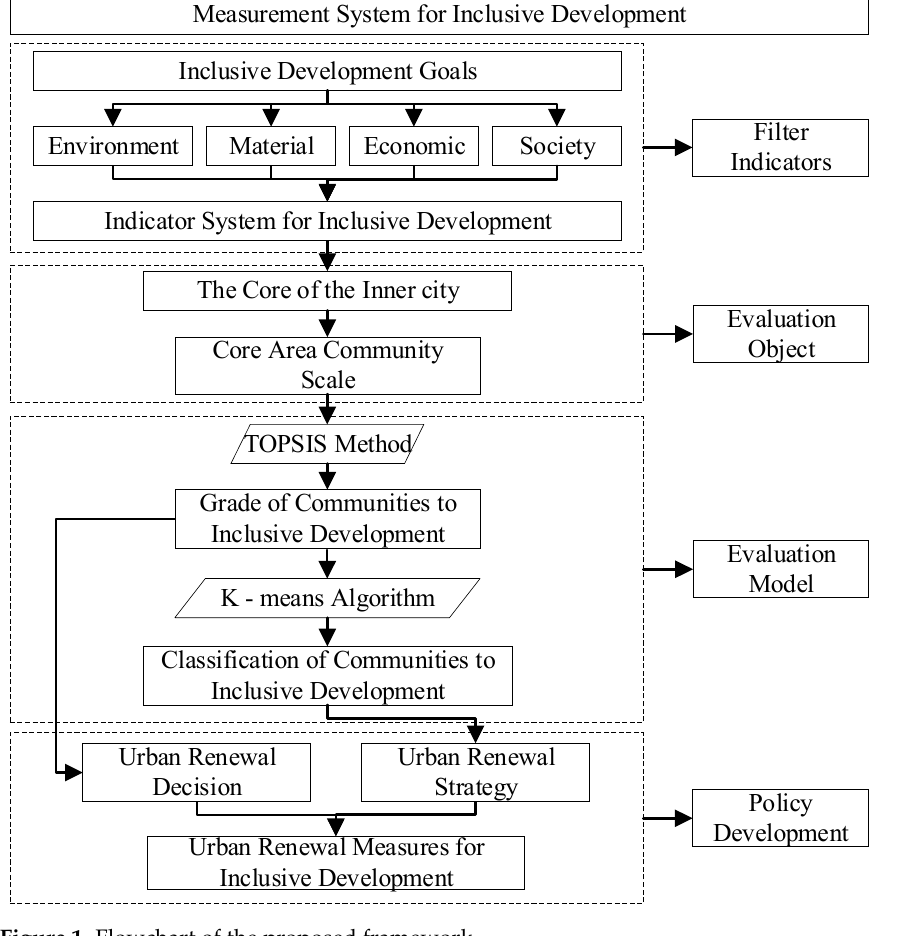
Figure 1. Flowchart of the proposed framework.